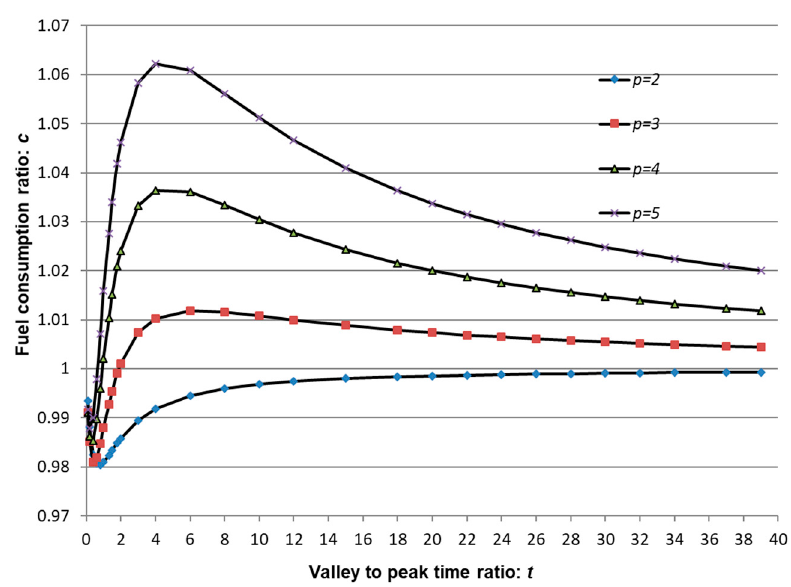
Figure 8. Fuel consumption ratio comparison ( η = 0.95 , r = r r ).